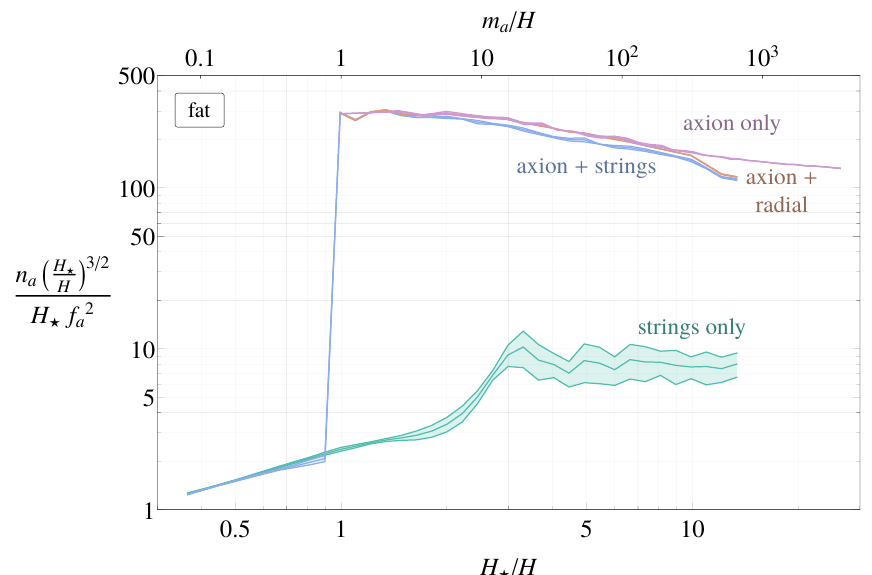
Figure 29: The evolution of the axion number density (extracted as twice the kinetic component of the number density) through the axion mass turn on, for α = 6. We compare simulations in which only the axion is dynamical (pink), starting with the initial field configuration predicted from the scaling regime with ξ ∗ log ∗ = 200, with results when the same axion spectrum is injected into a simulation of the axion and radial mode that has a string background evolved with a potential such that log (cid:63) = 7 (blue) (via eq. (19)). In the latter, the string network is in the scaling regime prior to the axion mass turn on, and is subsequently destroyed. We also plot the evolution of the same axion spectrum injected into a simulation of the axion and radial mode with no strings present (orange), and the result from the scaling regime without the addition of the extra axion field (light blue). The agreement between the results when the axion spectrum is evolved in complex scalar field simulations with and without strings shows that the presence of strings with log (cid:63) = 7 does not have a significant effect on the dynamics of the preexisting